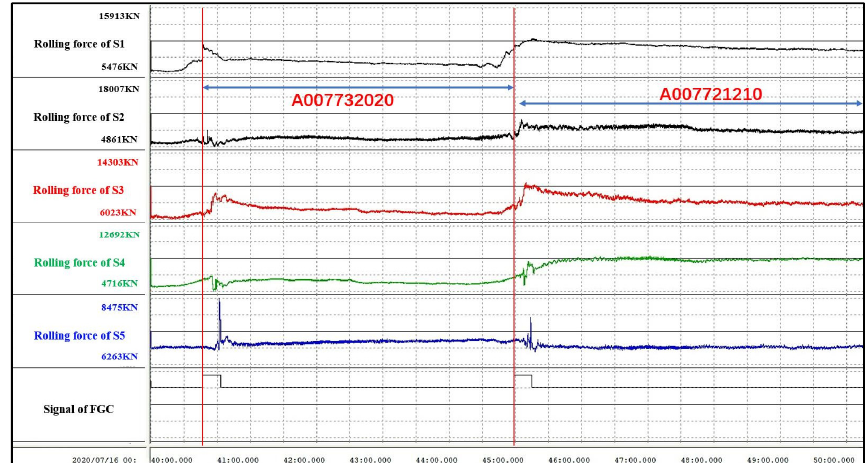
Figure 14. The rolling force of each stand after optimization.